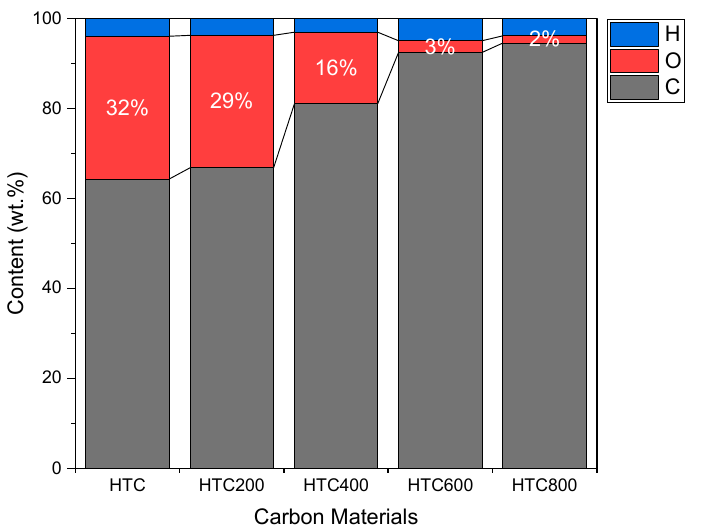
Figure 3. Composition analysis of as-synthesized HTC and samples annealed at 200–800 °C showing a significant reduction in the oxygen content of the materials. Annealing was performed under a flow of nitrogen (200 mL/min) using a heat ramp of 10 °C/min and a dwell time of 1 h at the target temperature.